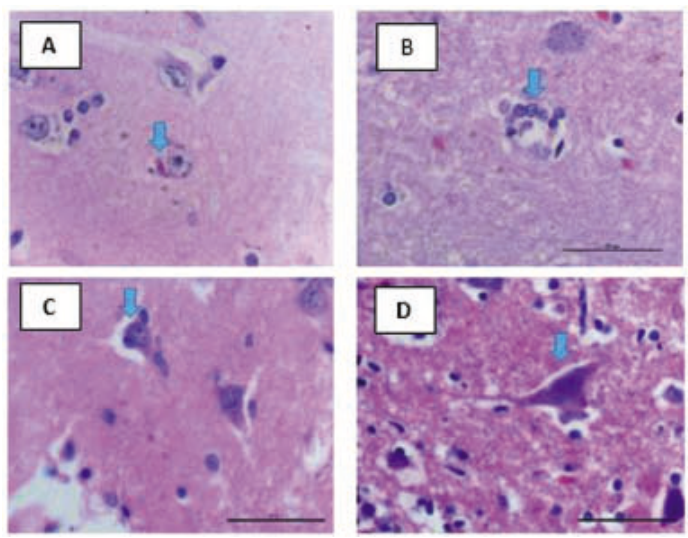
Figure 1. Histopathology of dog Hippocampus: A. Perinuclear lipofuscin accumulation in 8 years old dog (Case No. 287/21). B. Neuronophagia in 7 years old dog (Case No. 84/20). C. Satellitosis in 11 years old dog (Case No. 57//20). D. Chromatolysis of neuron in 4.5 months old dog (Case No. 59/21). (A. 400X., B, C & D. 1000X. H&E). The average number of neurons counted from the hilar region of the hippocampus using ten high power fields (400x) are represented in Table 1. Statistical analysis showed a mean value of the number of neurons in the hilus as 73.11±18.90 and 42.44±21.72 in the younger and aged dogs respectively. Analysis with an independent t-test described a statistically significant difference (P=0.006) in the mean value of the number of neurons in the hilar region of the hippocampus in aged and younger